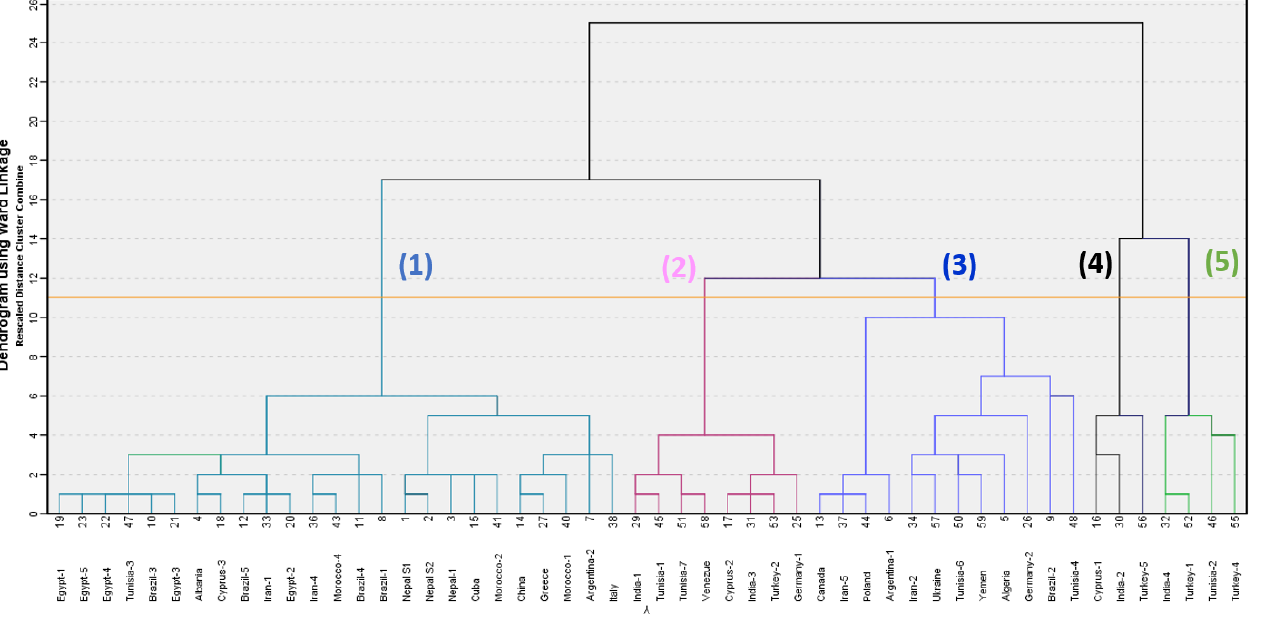
Figure 3. A dendrogram obtained from the agglomerative hierarchical cluster analysis of 52 Origanum majorana essential oil compositions. Numbers, (1), (2), (3), (4) and (5) represent different chemotypes dominated by terpinen-4-ol, cis -sabinene hydrate, trans -sabinene hydrate, linalool and carvacrol, respectively.